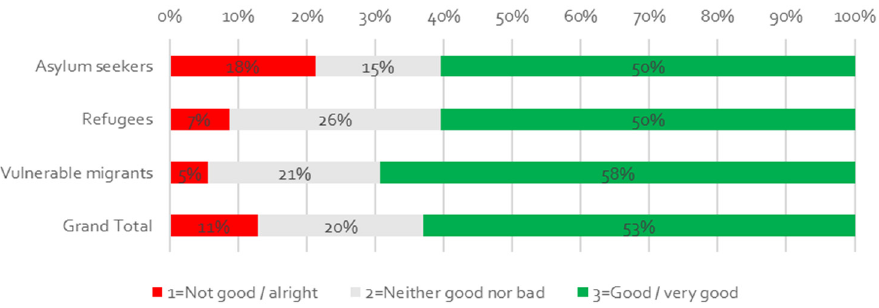
Figure 8. Average opinion NADINE recommender.